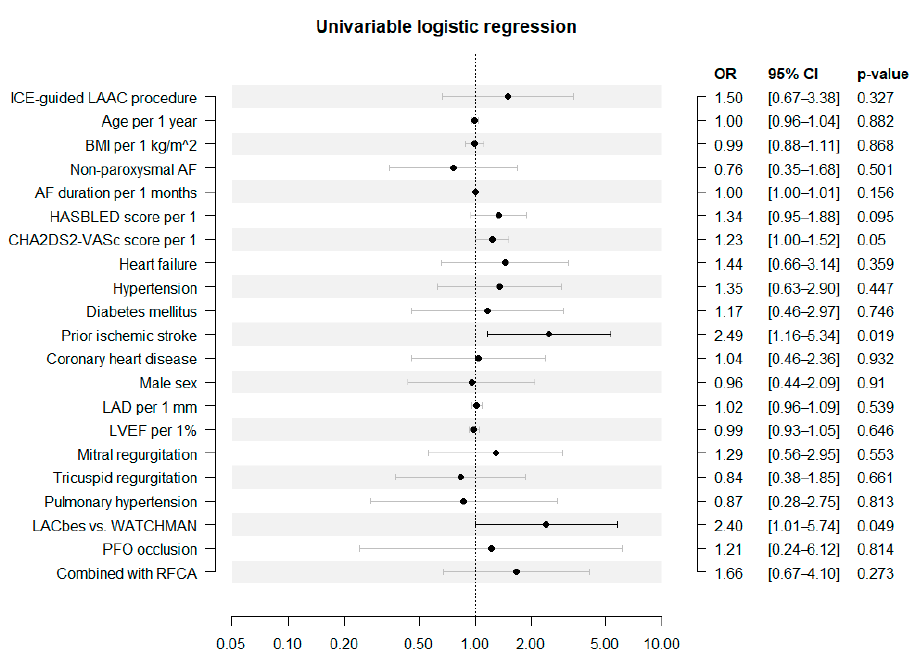
Figure 4. Predictors of patent iatrogenic atrial septal defect. ICE = intracardiac echocardiography; LAAC = left atrial appendage closure; BMI = body mass index; AF = atrial fibrillation; LAD = left atrial diameter; LVEF = left ventricular ejection fraction; PFO = patent foramen ovale; RFCA = ra- diofrequency catheter ablation.